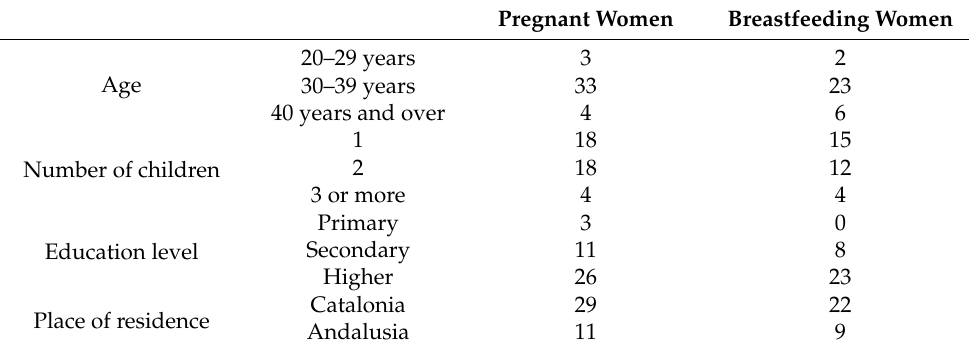
Table 1. First phase. Sociodemographic characteristics of the participants.